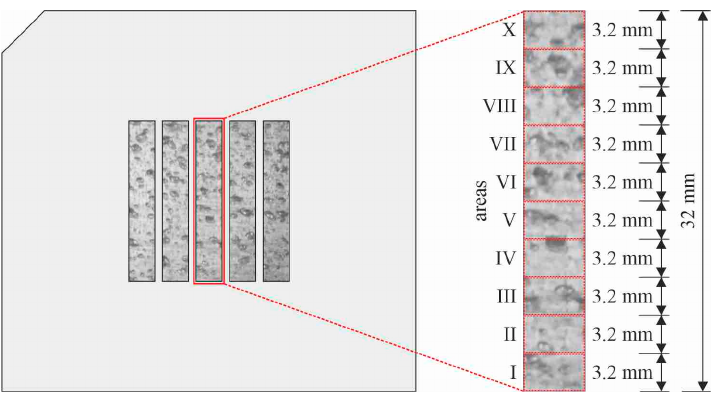
Figure 4. A scheme showing the distribution of areas corresponding to two-phase flow patterns, assumed for void fraction calculation.